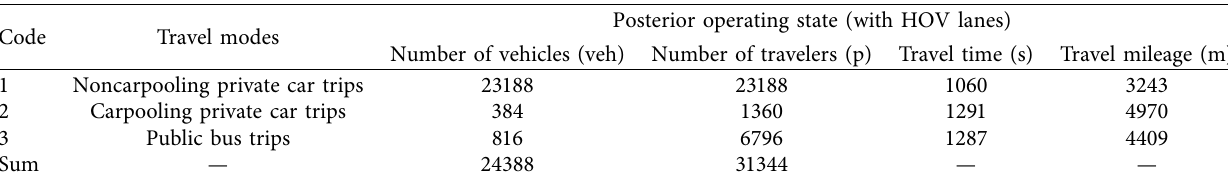
Table 13: Travel time and travel mileage of different travel modes in posterior operating state (with HOV lanes).